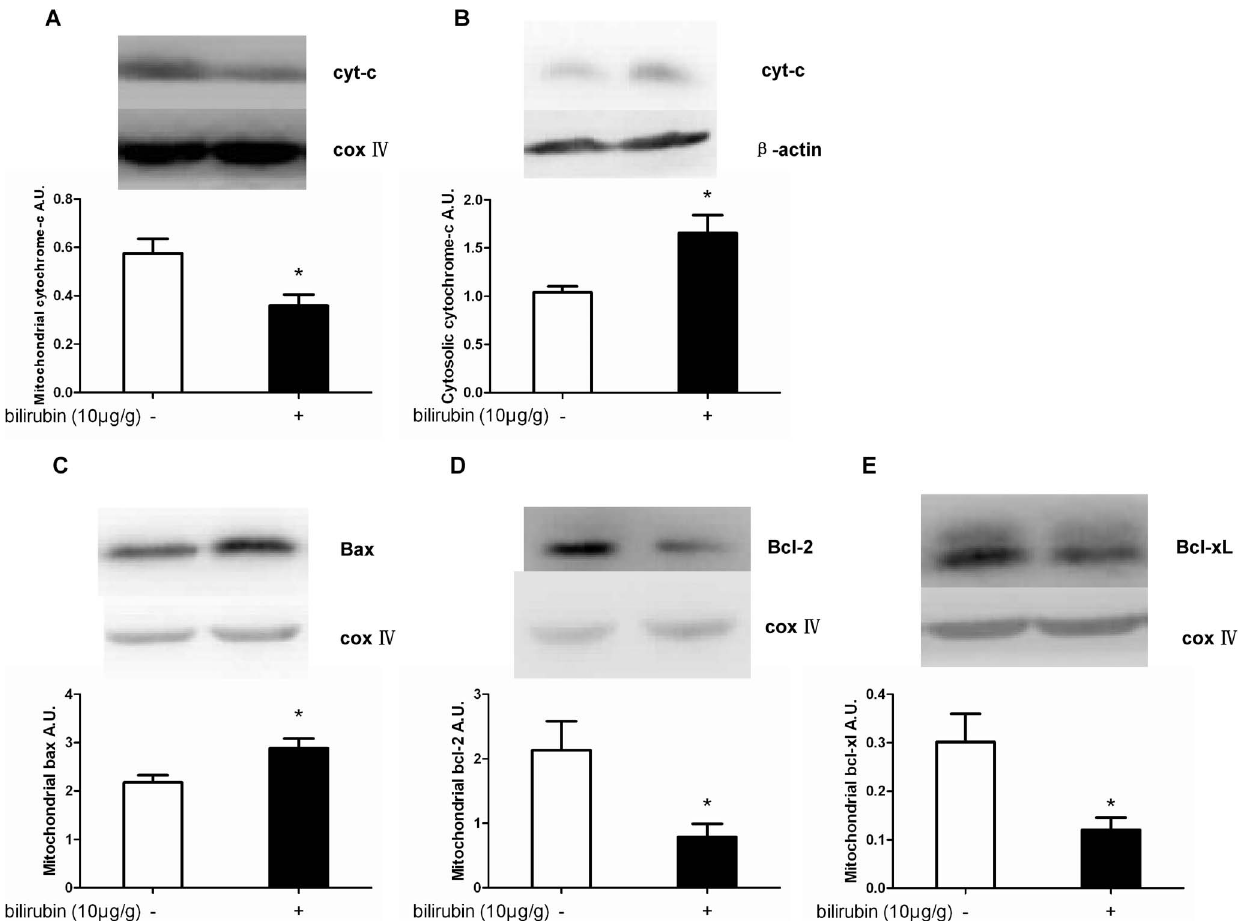
Figure 5. Effects of bilirubin on apoptosis-related molecules in the hippocampus at 24 hours after bilirubin injection. At 24 h after bilirubin injection, mitochondrial cytochrome-c (A) levels were significantly decreased compared with the control group; simultaneously, the cytosolic cytochrome-c (B) levels were significantly increased compared with the controls. Additionally, a significant increase of Bax in mitochondria (C) was observed. Meanwhile, Bcl-2 and Bcl-xL (D, E) expression in the mitochondria was dramatically decreased compared with the controls. (n=12 in each group). *: P , 0.01 vs the control group.